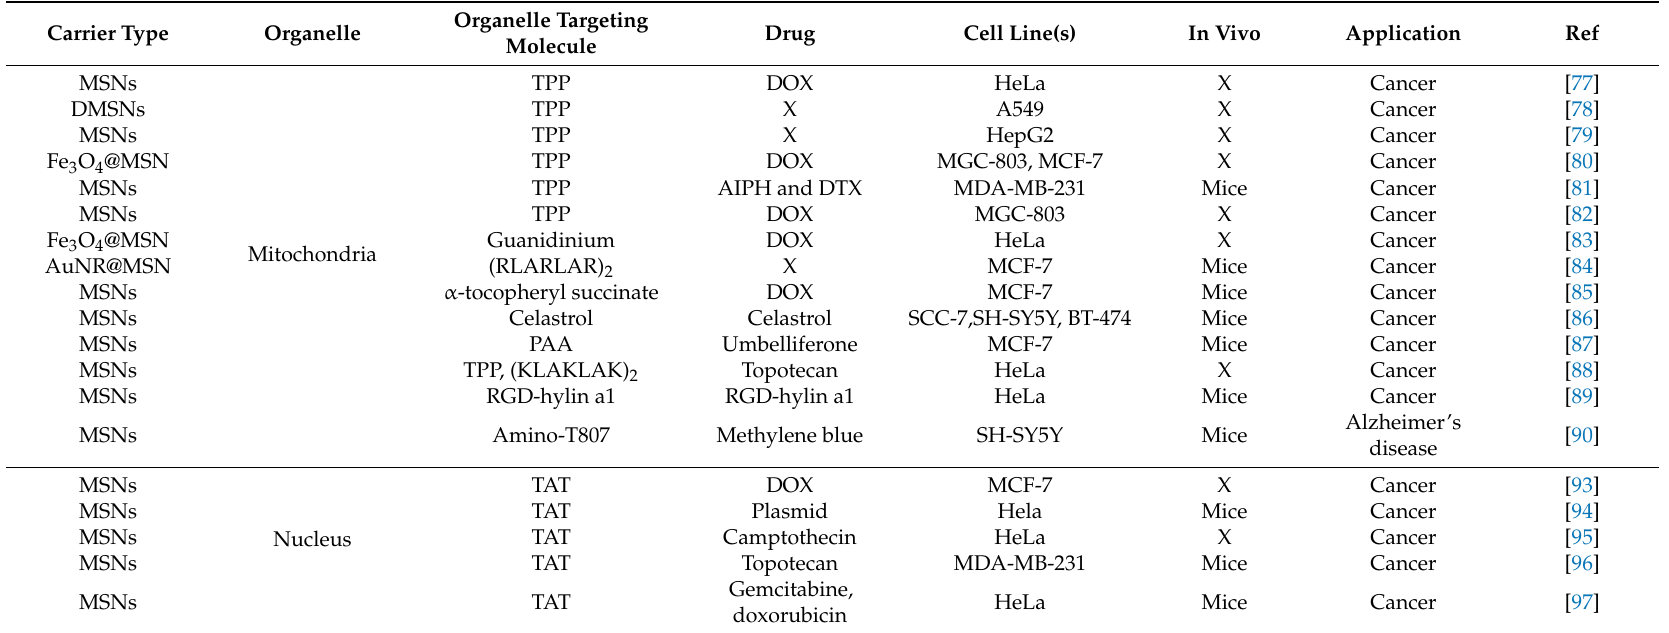
Table 1. Di ff erent approximations for the design of organelle-targeted